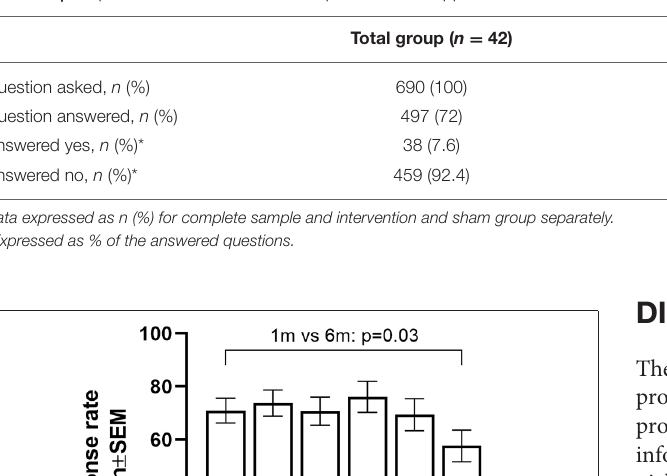
TABLE 2 | Response rate to the medication question in the application.